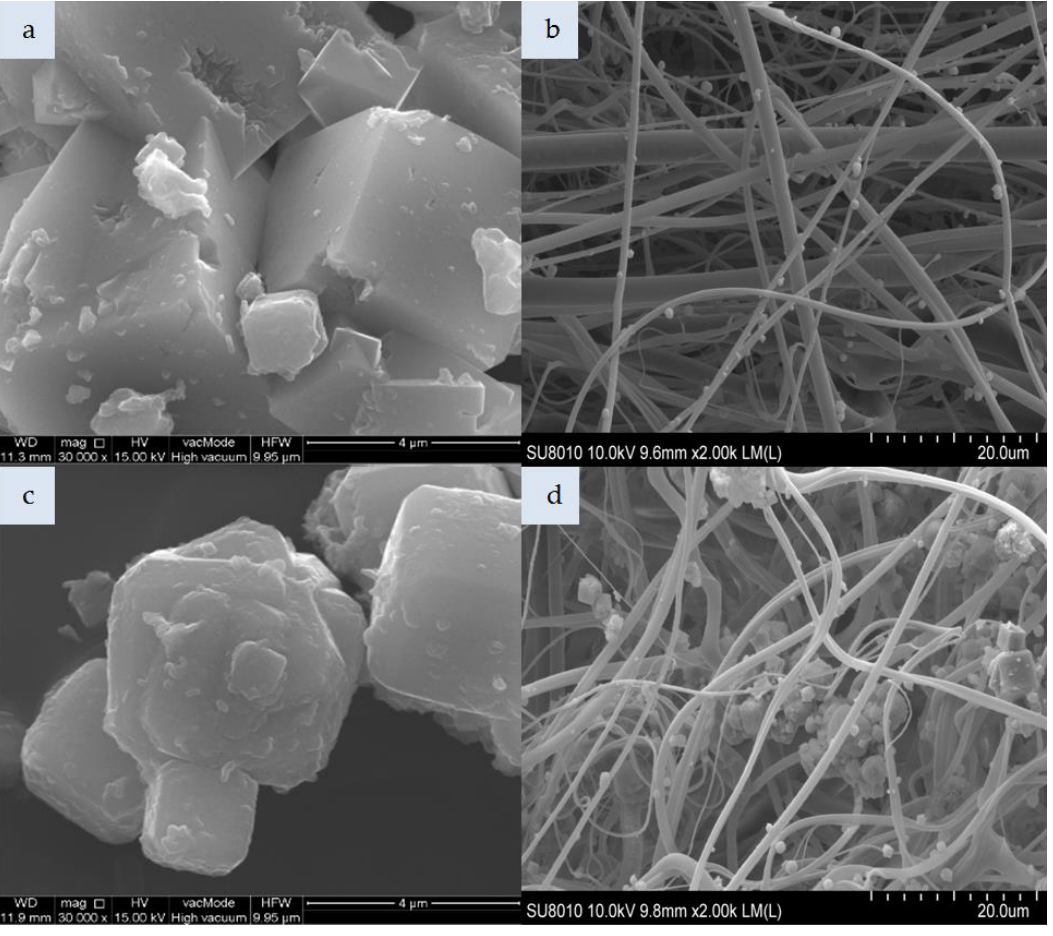
Figure 2. SEM photomicrograph: ( a ) Unmodified zeolite Na-A, ( b ) nonwoven composite with Na-A, ( c )zeolite Na-A HDTMA, ( d )nonwoven composite with Na-A HDTMA (magnification: a,c – x30.00k; b,d – x2.00k).